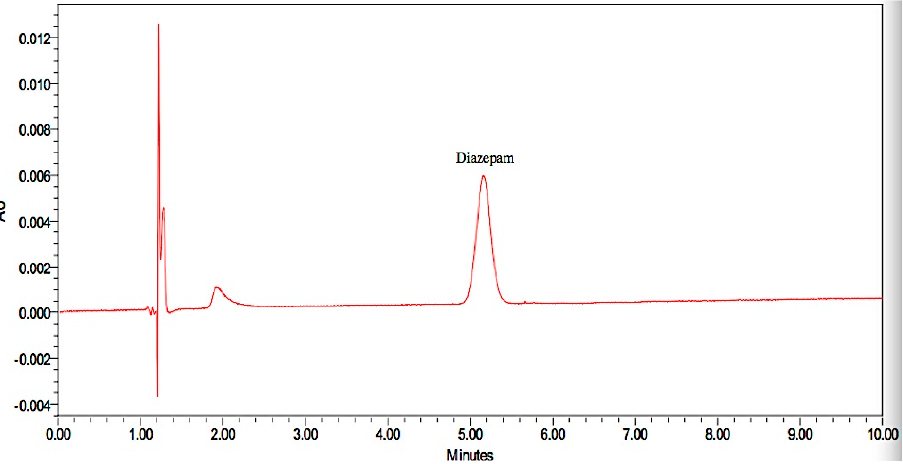
Figure 8. Representative chromatograms of the diazepam drug sample.